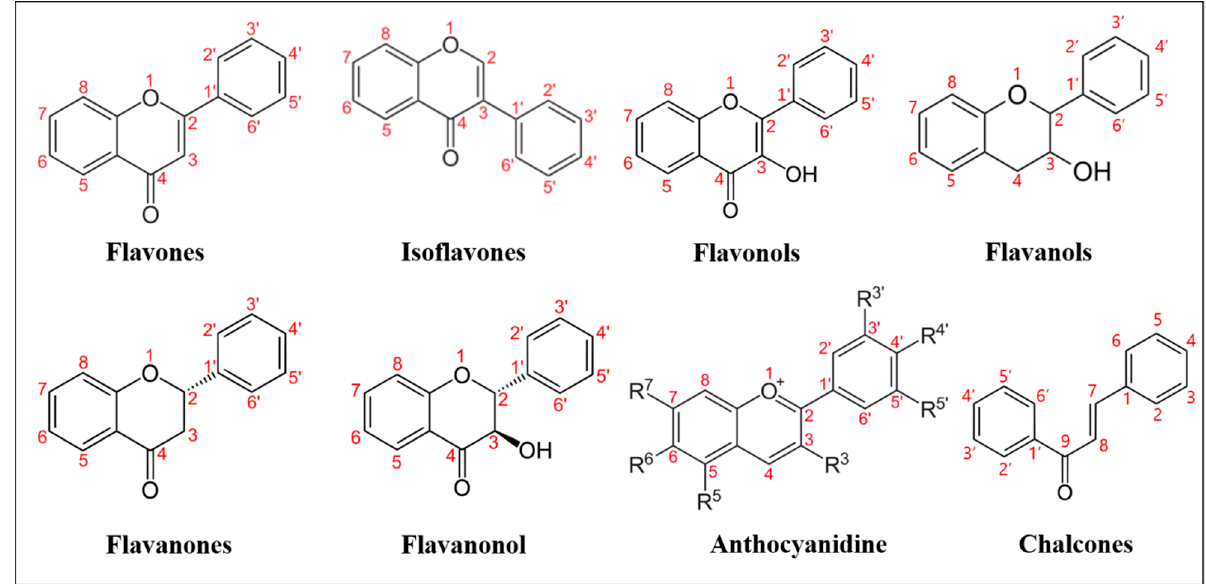
Figure 1. Basic structures of the main flavonoid classes.